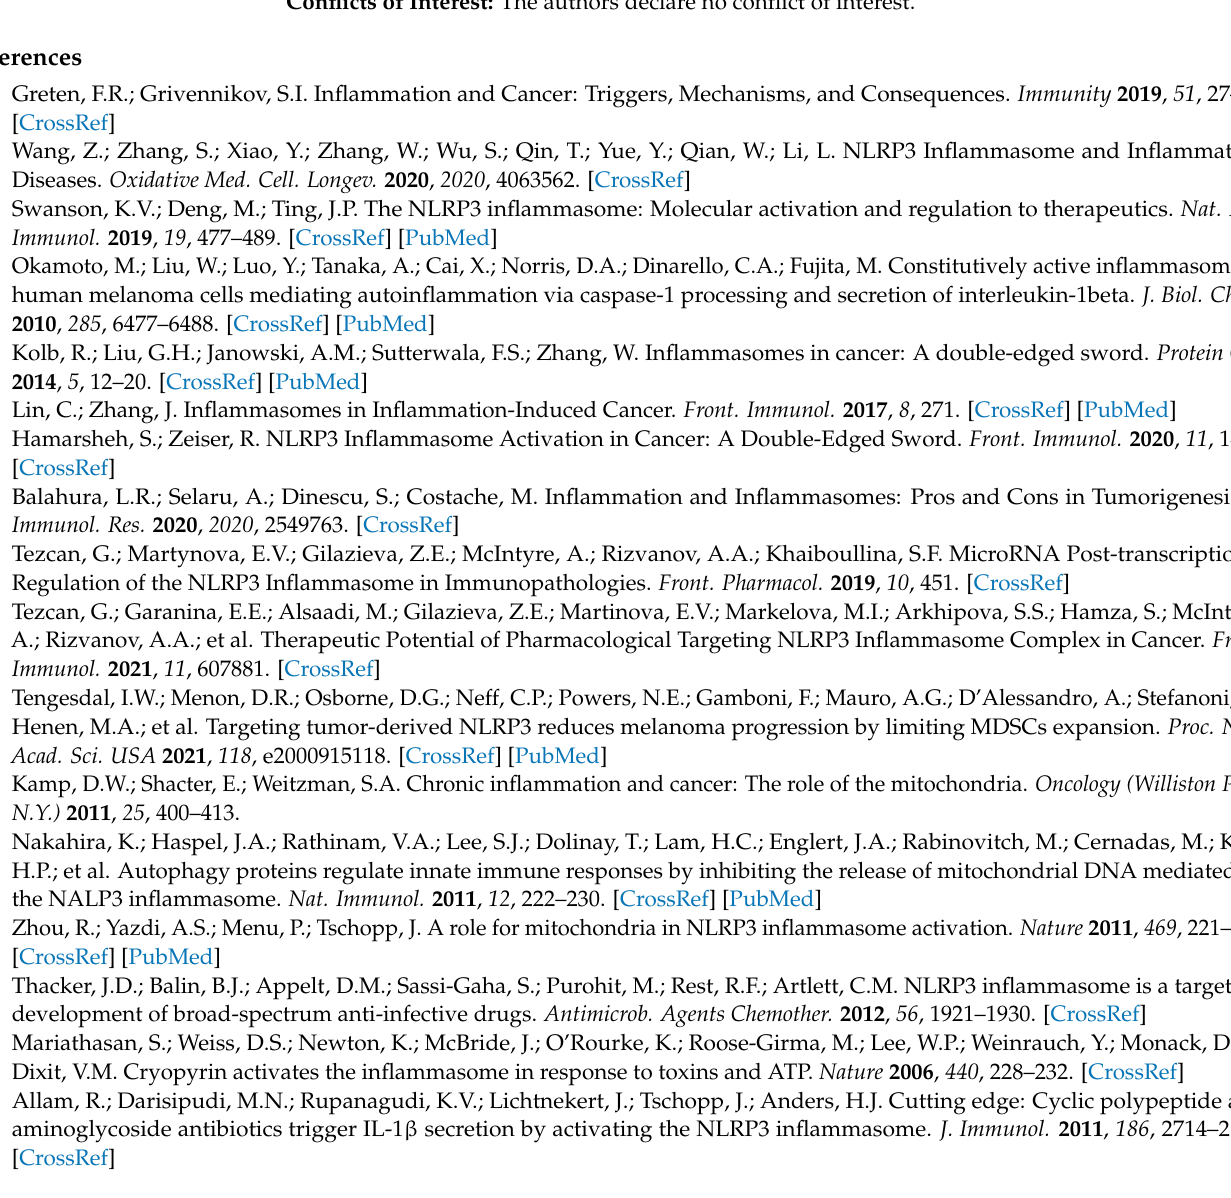
Table S3: The effect of Doxycycline on cytokine releasing pattern of PC3 cells, Table S4: The effect of Doxycycline on cytokine releasing pattern of A549